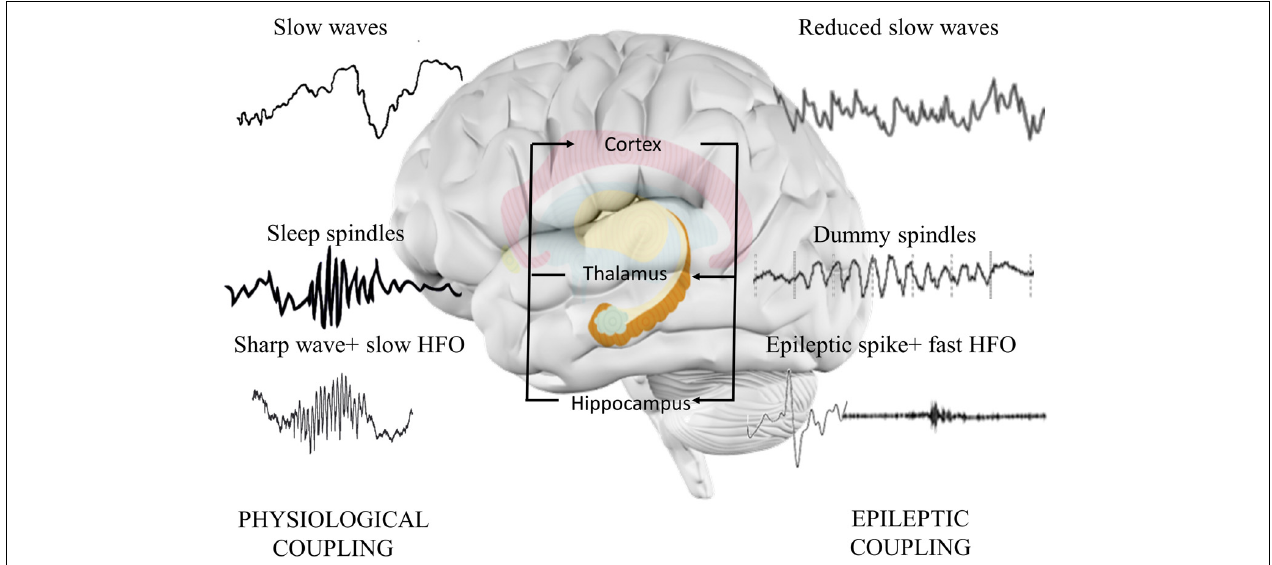
FIGURE 3 | Hippocampo-thalamo-cortical coupling in memory consolidation. In physiological memory consolidation process, synchronization of the hippocampus, thalamus, and neocortex is essential. Hippocampal sharp-wave ripples correspond to the replay of recently stored memory items in the synaptic connections of hippocampal neurons. Thalamic sleep spindles with a frequency of 12–16 Hz are essential elements of memory formation, synchronizing hippocampal activity with cortical neurons. Cortical sleep-related slow waves provide the highest synchronization state to facilitate the activation of hippocampal sharp-wave ripples and thalamic sleep spindles. Epileptic discharges correspond to the pathological transformation of sharp waves coupling with faster high frequency oscillations. The altered activity disorganizes the architecture of spindles, decreases the normal spindle activity, and induces the formation of dummy spindles with longer duration and spiky appearance. Cortical slow waves are also reduced, probably due to the spike-inducted cortical hyperpolarization (downstates). Alterations might reduce the efficacy of memory consolidation process.